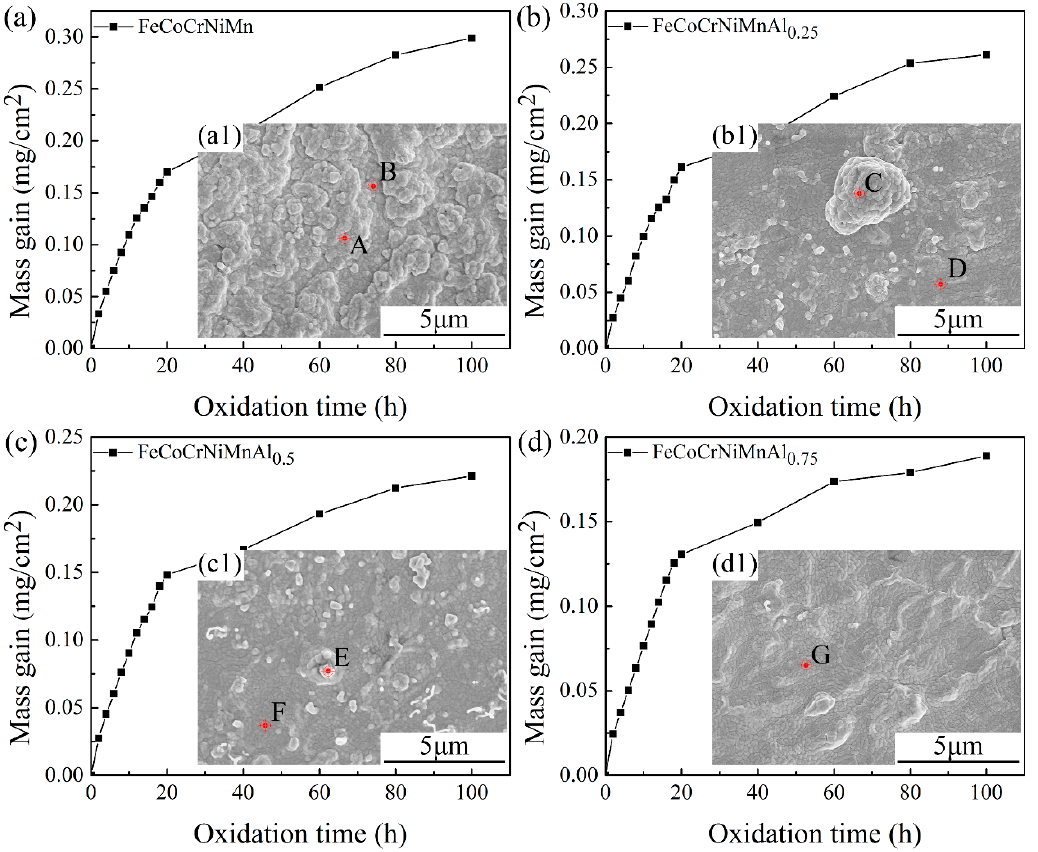
Figure 5. Oxidation mass gains and microstructures of surface oxides of the FeCoCrNiMnAl x cladding layers: ( a , a1 ) x = 0; ( b , b1 ) x = 0.25; ( c , c1 ) x = 0.5; ( d , d1 ) and x = 0.75. Table 4. EDS results of oxides on the surface of the FeCoCrNiMnAl x cladding layers (at.%). Elements